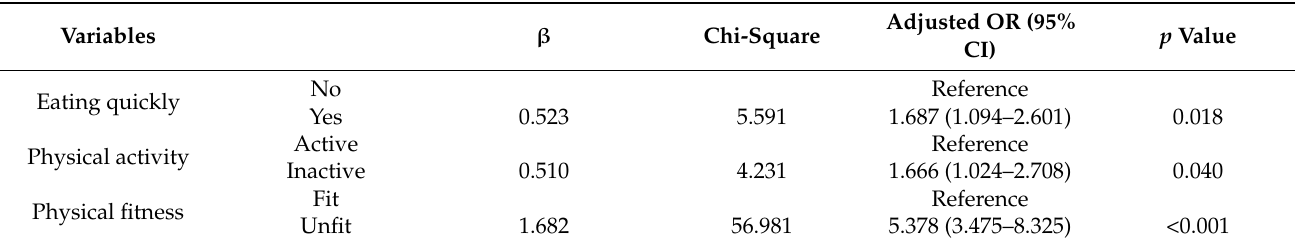
Table 4. Odds ratios and 95% confidence intervals for metabolic syndrome according to risk factors in a multivariate logistic